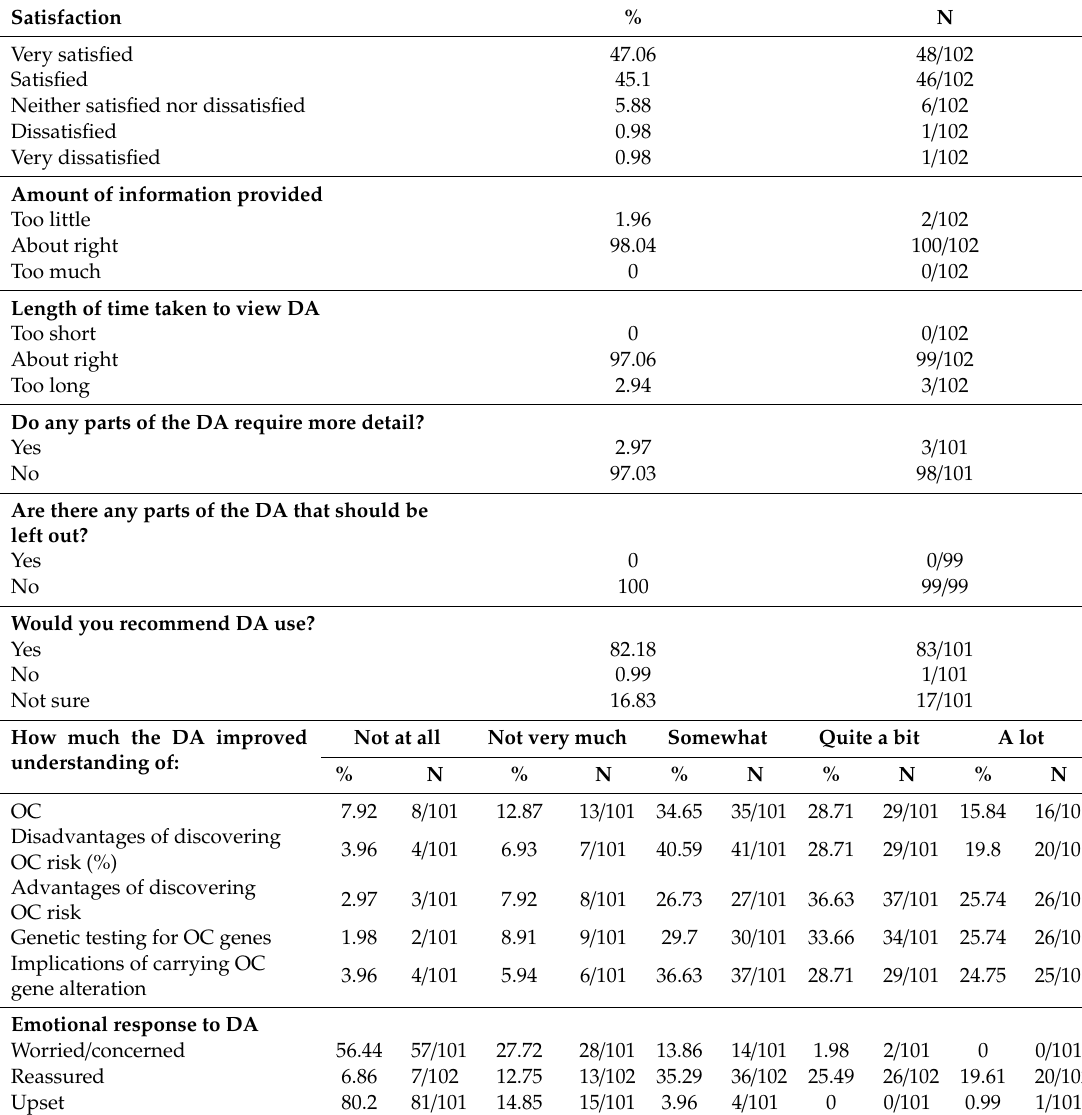
Table 2. Decision aid evaluation questionnaire